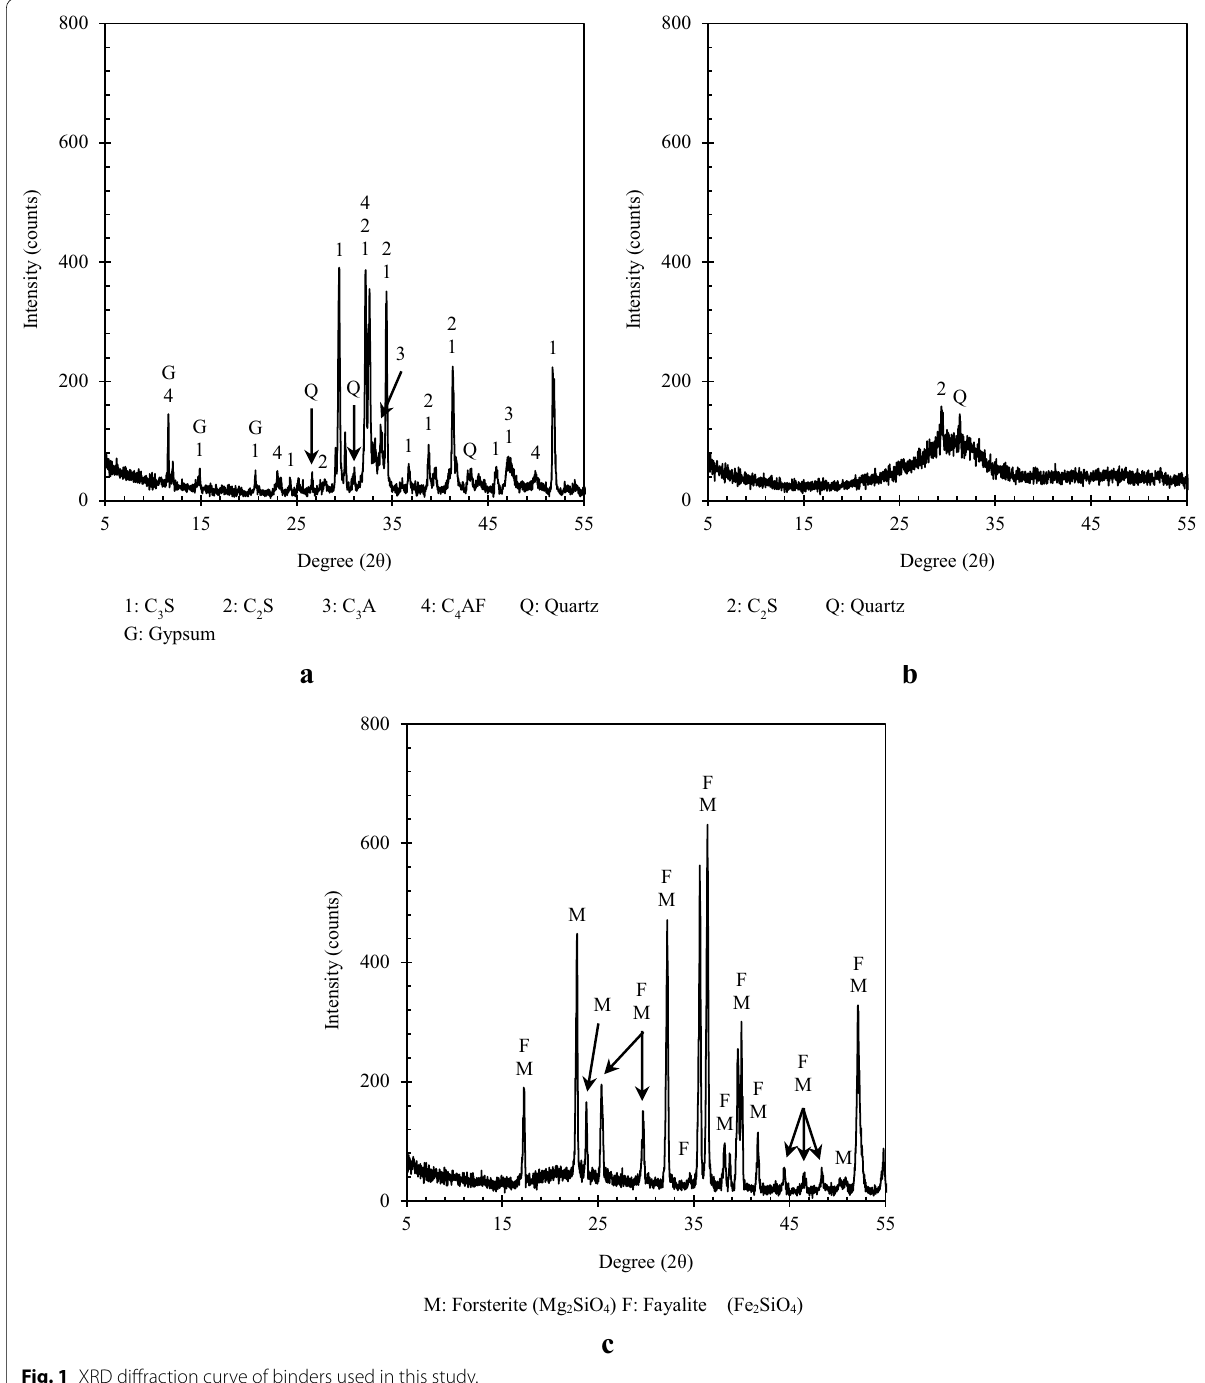
Fig. 1 XRD diffraction curve of binders used in this